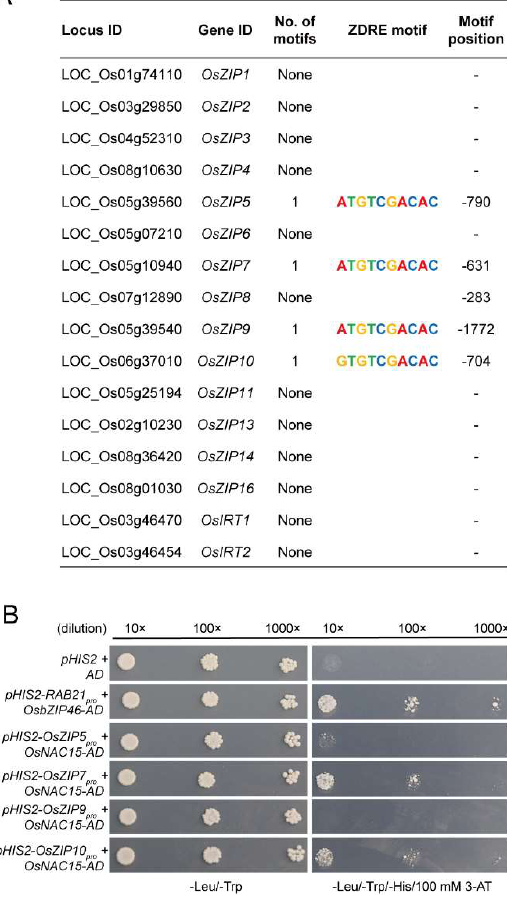
assay to test the binding in vitro. GST-OsNAC15 fused protein directly binds the OsZIP7